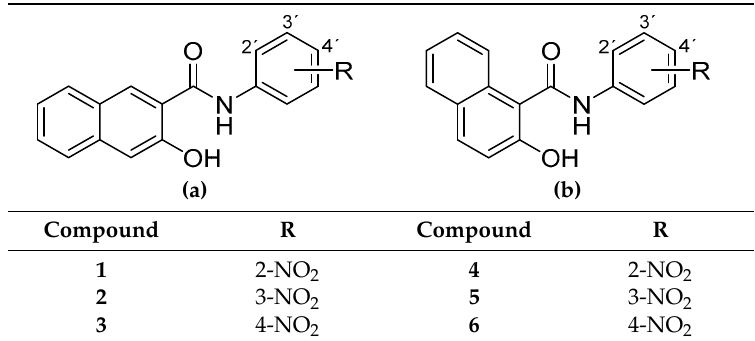
Table 1. Structures of tested compounds: ( a ) 3-hydroxy- N -(nitrophenyl)naphthalene-2-carboxamides; and ( b ) 2-hydroxy- N -(nitrophenyl)naphthalene-1-carboxamide.